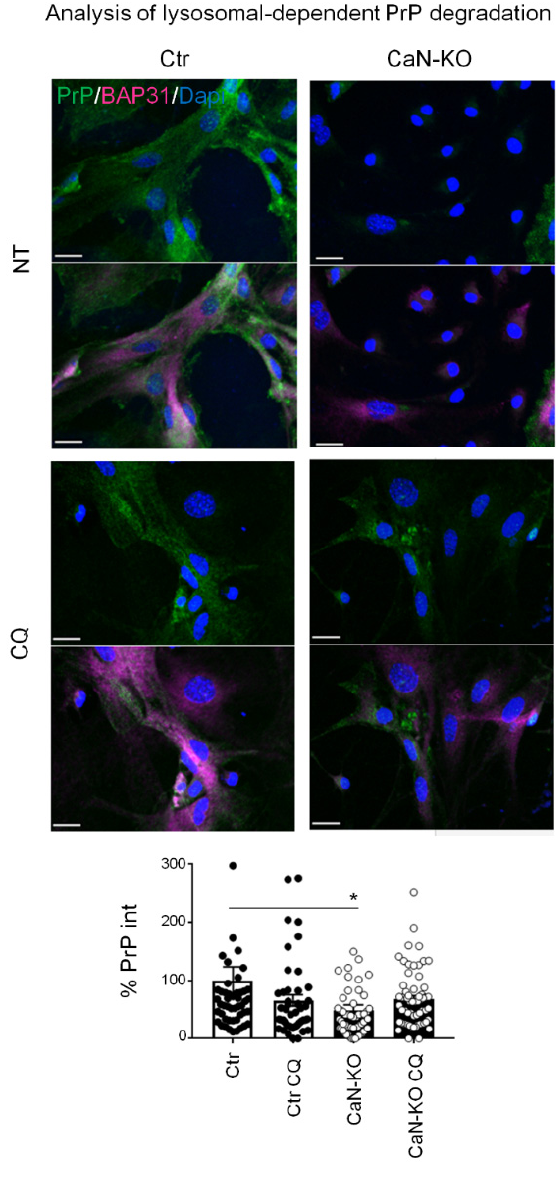
Figure 5. Analysis of lysosomal-dependent PrP C degradation. Ctr and CaN-KO astrocytes were untreated or treated with chloroquine (CQ) before immunofluorescence with anti PrP (green), BAP31 (pink) antibodies and reacted with DAPI to stain the nuclei (blue). Confocal microscope analysis, scale bar 20 µm. Quantification of total PrP C fluorescence density expressed as percentage of Ctr. Data are the means ± SEM of Ctr n = 49 cells, Ctr CQ n = 46 and KO n = 58 cells; KO CQ = 62, from three to seven coverslips from three independent experiments, * p < 0.05.